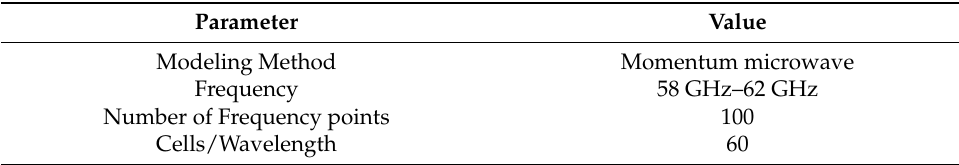
Table 2. Simulation characteristics.